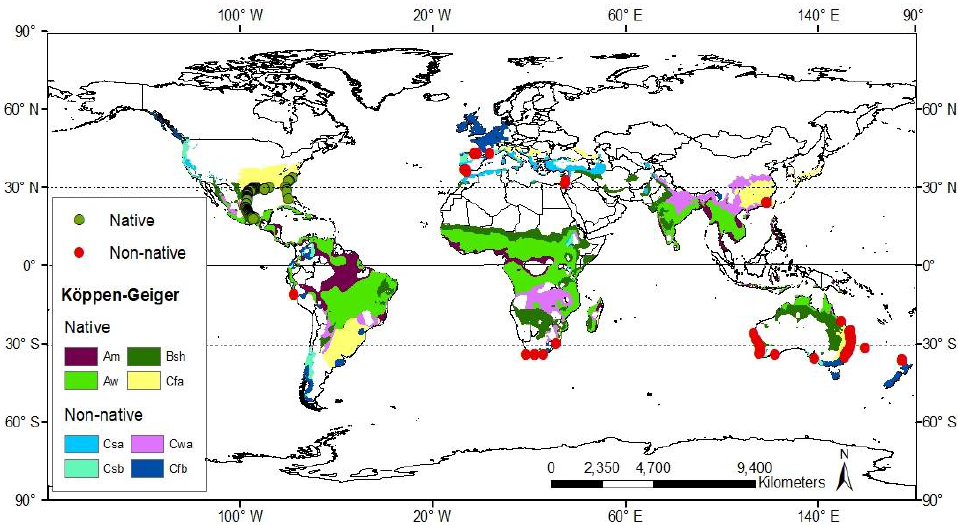
Figure 2. Köppen–Geiger climatic region where O. drummondii subsp. drummondii Hook is distributed. Red dots show native and non-native geographic distribution of the species. Köppen–Geiger climatic native regions: Tropical monsoon climate (Am), Tropical savanna climate with dry-winter characteristics (Aw) hot semi-arid climate (Bsh), and Humid subtropical climate (Cfa). Köppen–Geiger climatic non-native regions: Mediterranean hot summer climates (Csa), Mediterranean warm/cool summer climates (Csb), Temperate oceanic climate (Cfb), Dry-winter humid subtropical climate (Cwa). Solid black line represents the Line of Ecuador and dashed lines represent the intertropical region. Table 1. Bioclimatic variables selected for each of the corresponding Köppen–Geiger climatic regions of the species dis- tribution areas. Bio1: Annual Mean Temperature, Bio3: Isothermality (BIO2/BIO7) (×100), Bio4: Temperature Seasonality